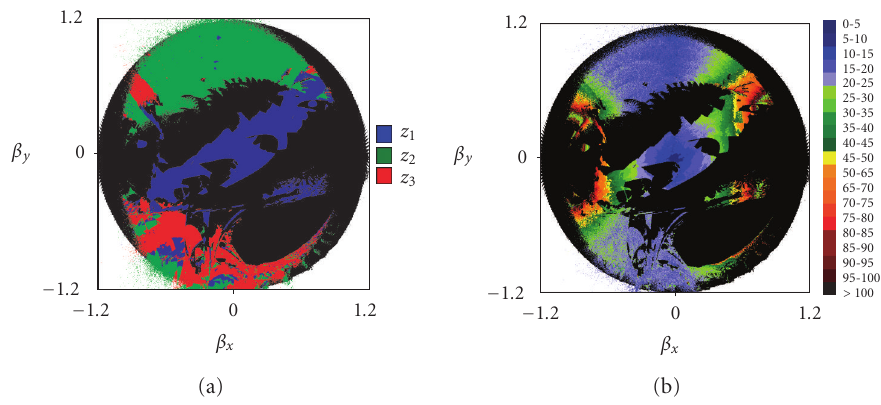
Figure 4.8. Disks of convergence (cid:3) ( − 1 . 2+ i , β ) with